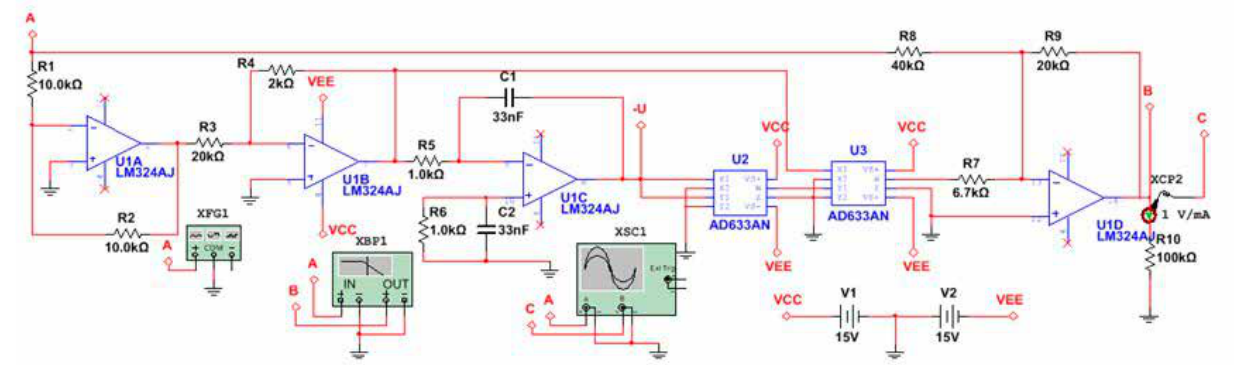
Figure 1: The equivalent circuit of the flux-controlled smooth cubic memristor.